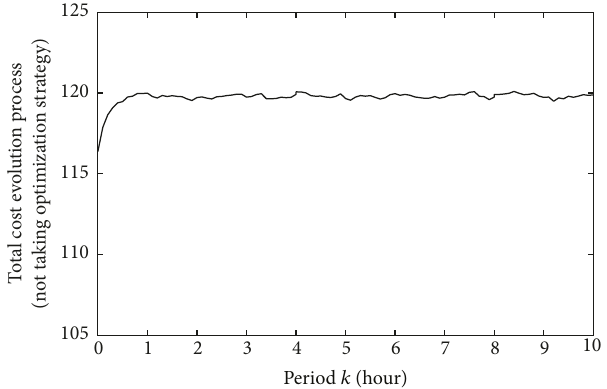
Figure 6: Evolution process of total cost without cost optimization strategy ( ×10 5